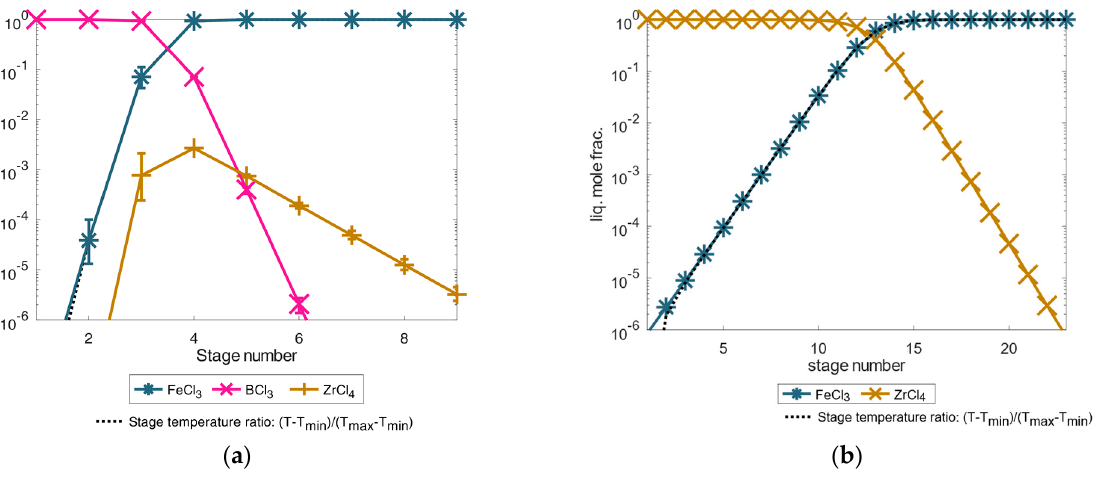
Figure 9. Illustration of high-purity boron trichloride ( a ) and zirconium tetrachloride ( b ) separation excerpt example by high-pressure distillation at 2500 kPa, simulated in an exemplary total-reflux column under simplified idealized phase equilibrium conditions according to Equation (1). The error bars show the results for a deviation of the calculated temperature of ±